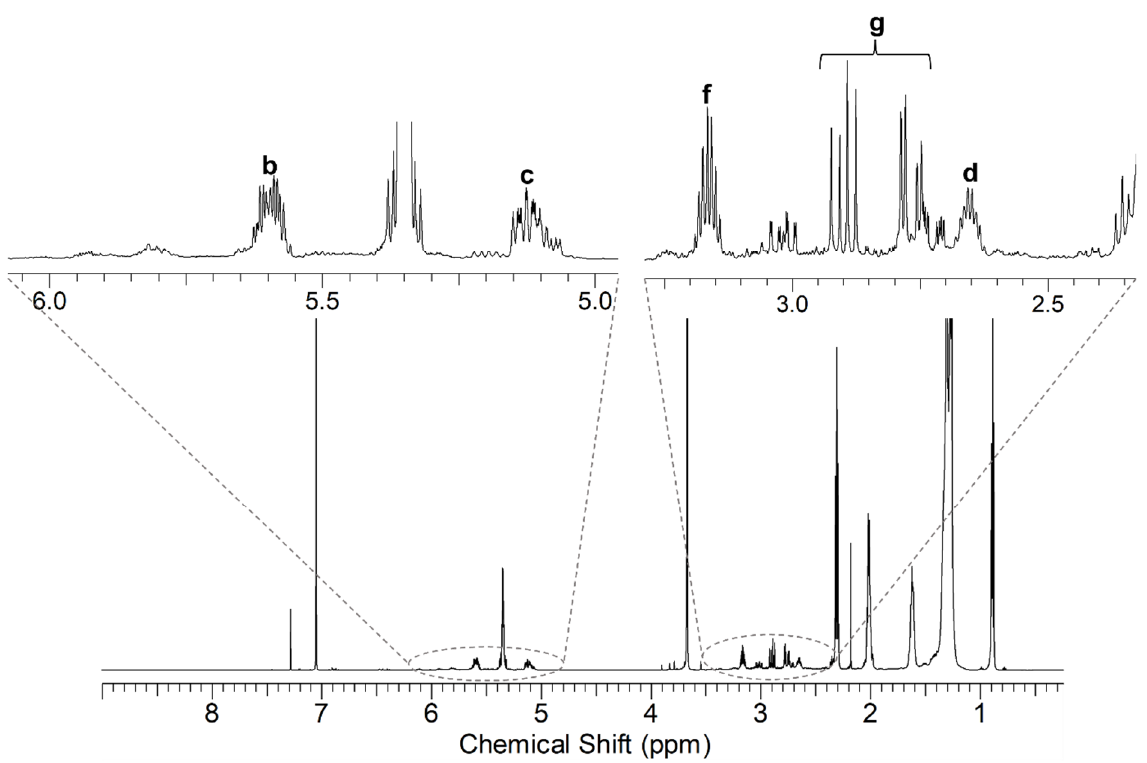
Figure 4. 1 H NMR spectrum of the reaction product of methyl oleate with MA (under MW activation). The protons of the alkenyl succinic anhydride group are labeled according to Figure 3.